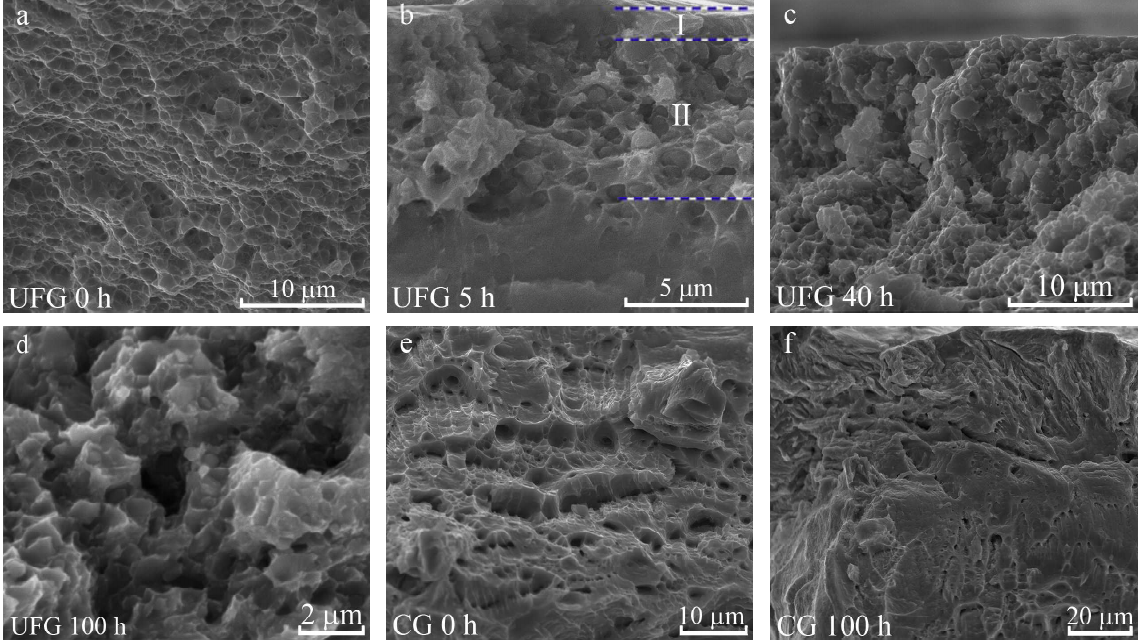
Fig. 14. SEM micrographs of the fracture surfaces of the UFG-CrNiTi (a-d) and CG-CrNiTi (e, f) steel specimens depending on hydrogen-charging duration: a, e – hydrogen-free, b – hydrogen-charged for 5 hours, c – hydrogen-charged for 40 hours, d, f – hydrogen-charged for 100 hours. Table 3. Micromechanisms of fracture and width of the hydrogen-assisted surface layers in ultrafine-grained CrNiTi and CrNiMo